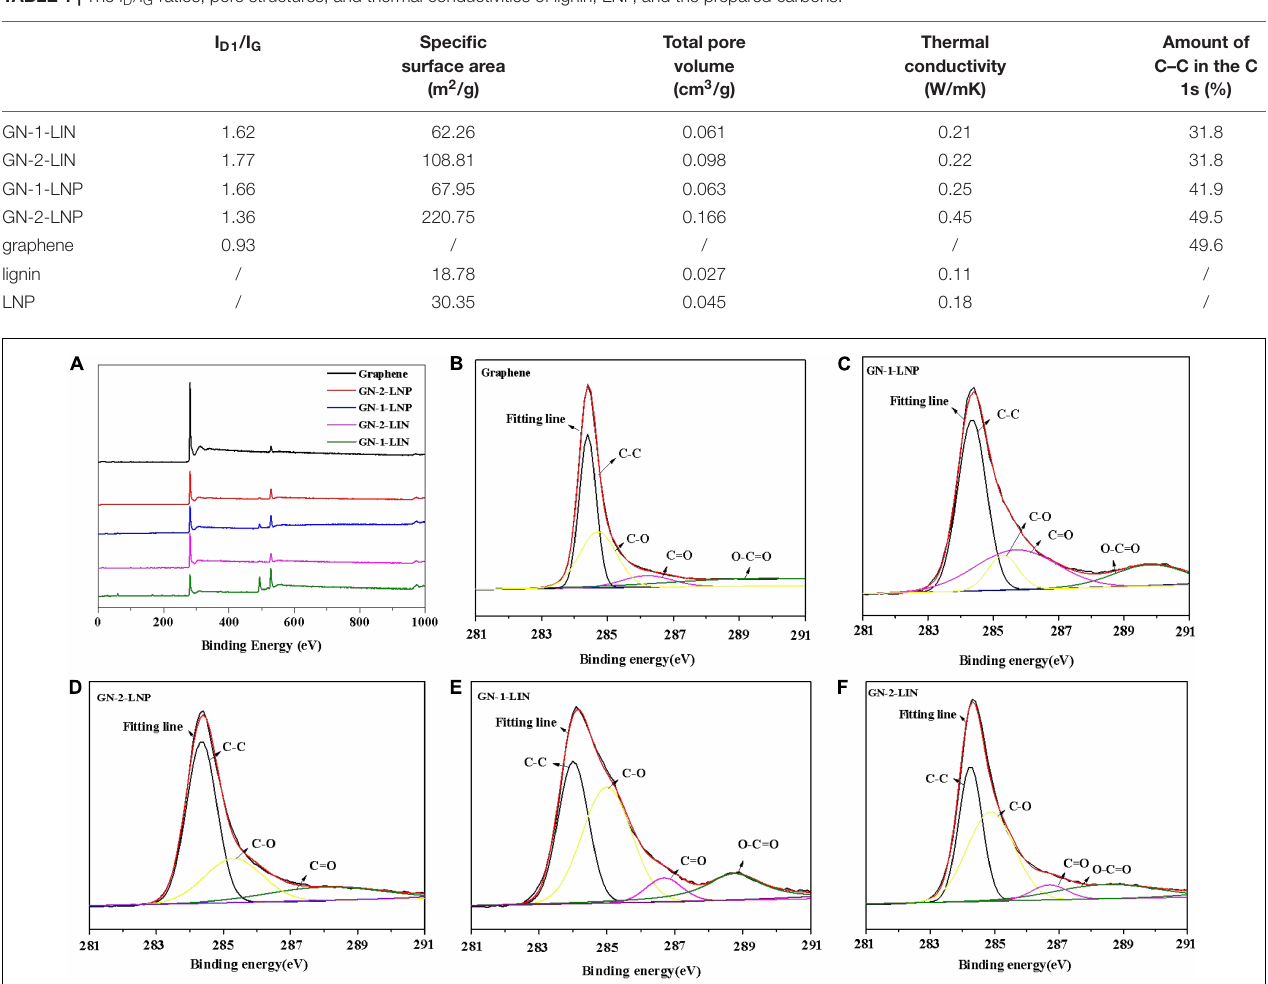
TABLE 1 | The I D /I G ratios, pore structures, and thermal conductivities of lignin, LNP, and the prepared carbons.